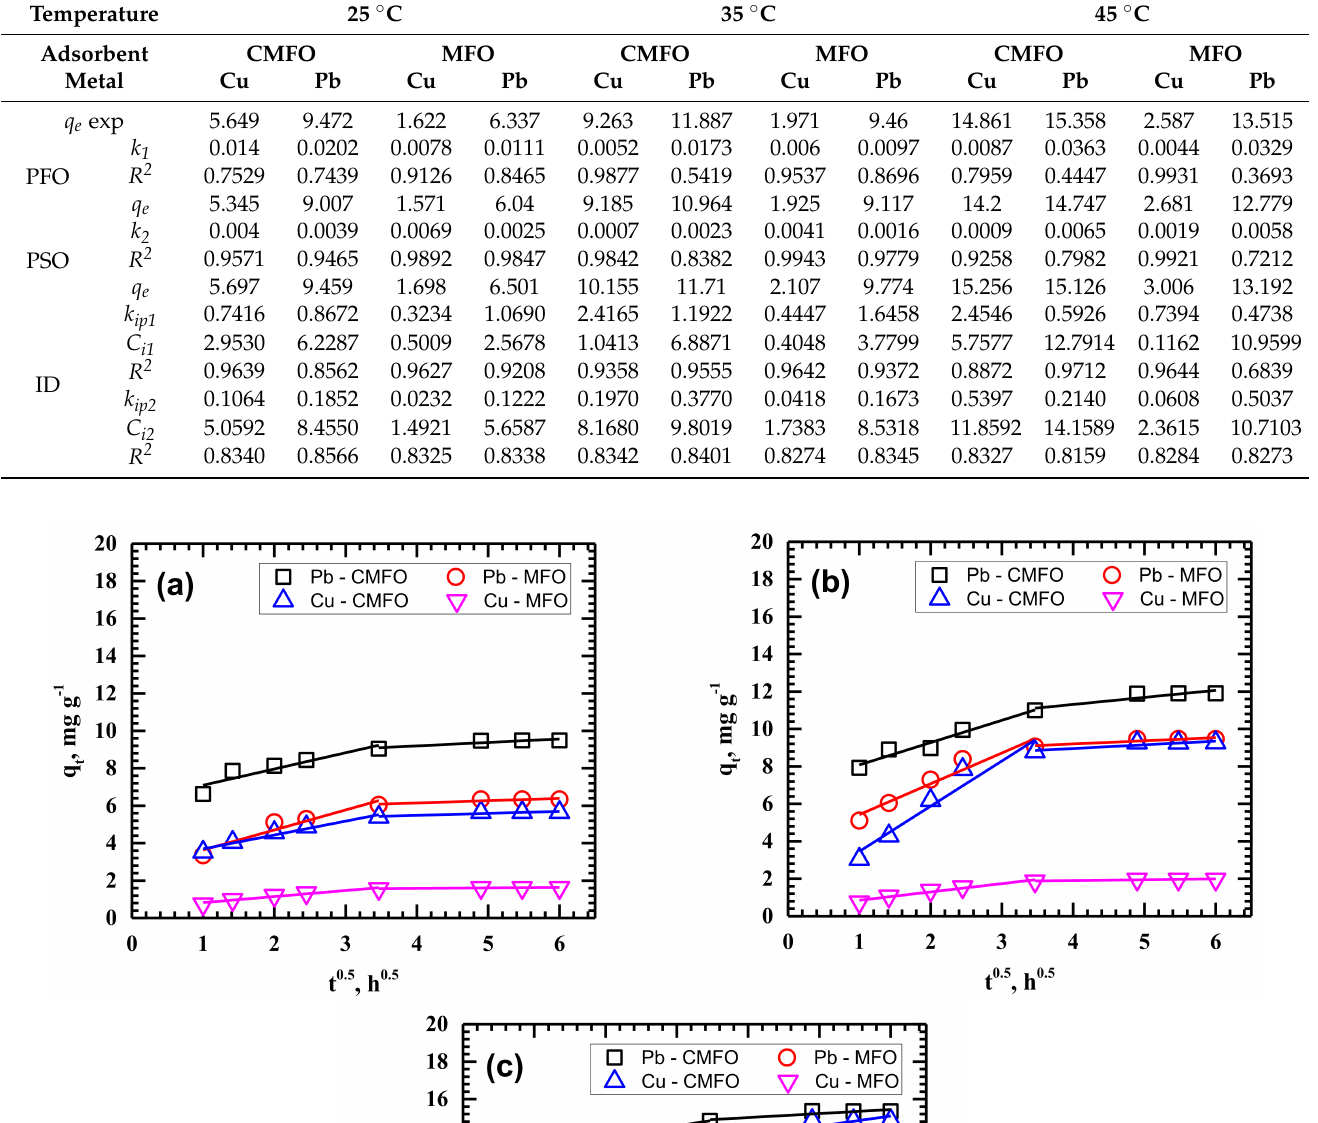
Table 1. Pseudo-first order, pseudo-second order, and intraparticle diffusion kinetic parameters for Cu(II) and Pb(II) uptake by CMFO and MFO at varying solution temperatures.